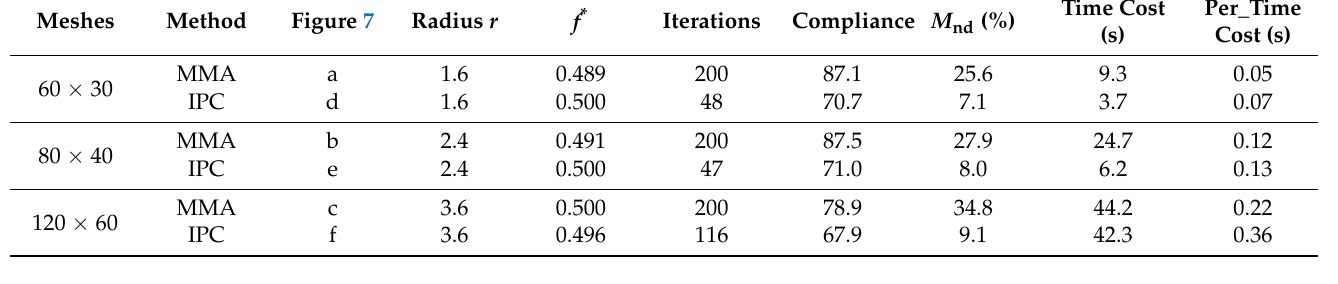
Table 2. Optimization data for different methods and finite element meshes.